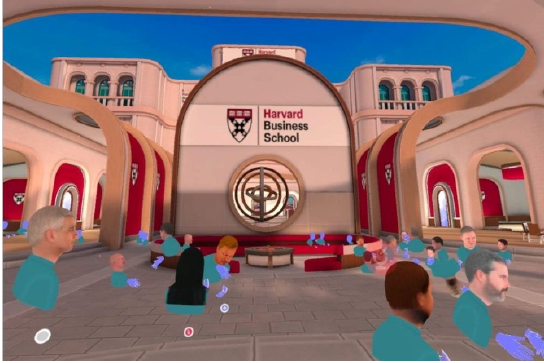
Figure 25: Harvard University Alumni Reunion Legal Proceedings in the Metaverse